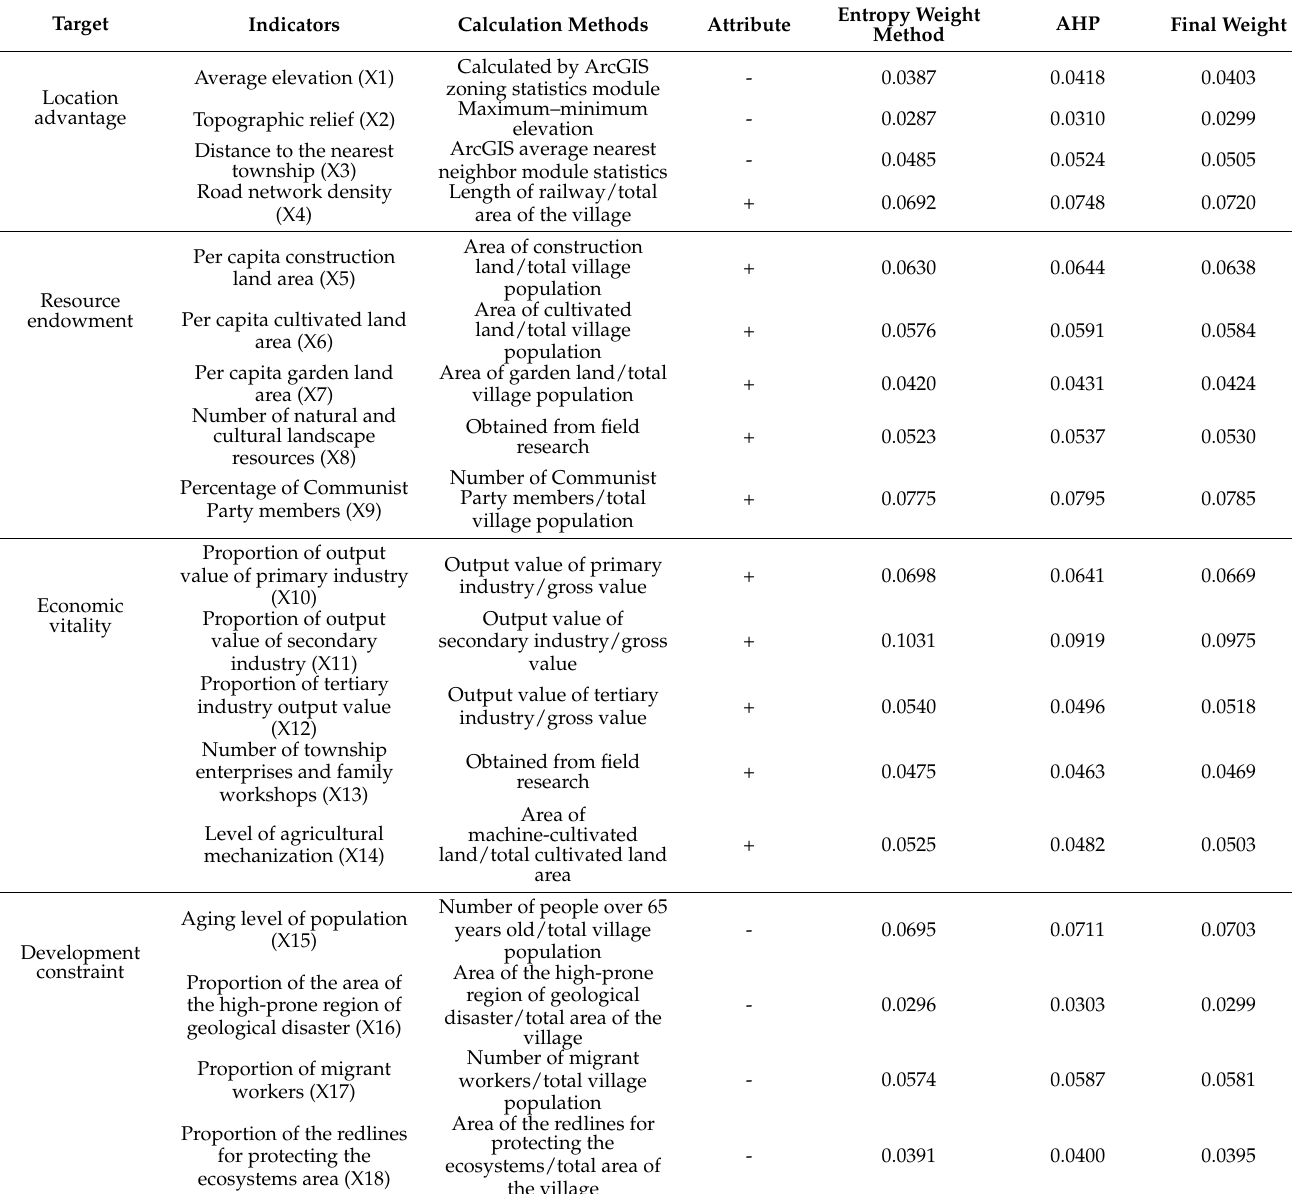
Table 2. Evaluation index system of rural development